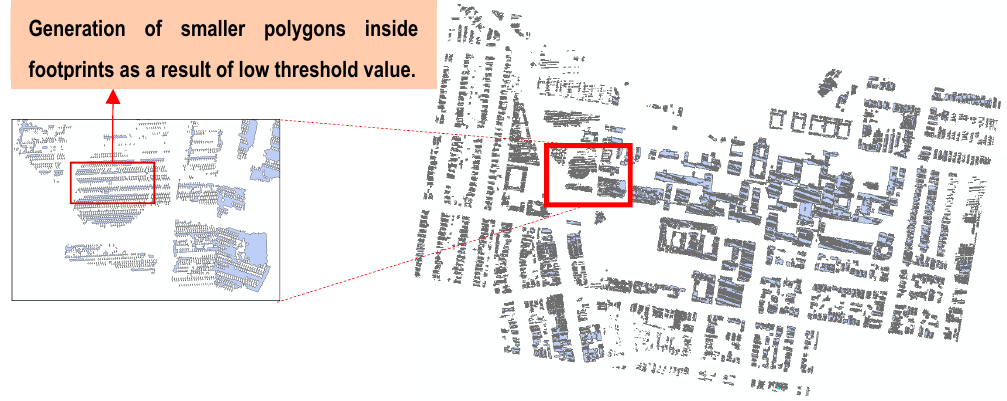
Figure 12. Demonstration of the results of aggregate points in geographic information system (GIS) for extraction of buildings boundaries with 1.5 m aggregate distance in the selected data set.